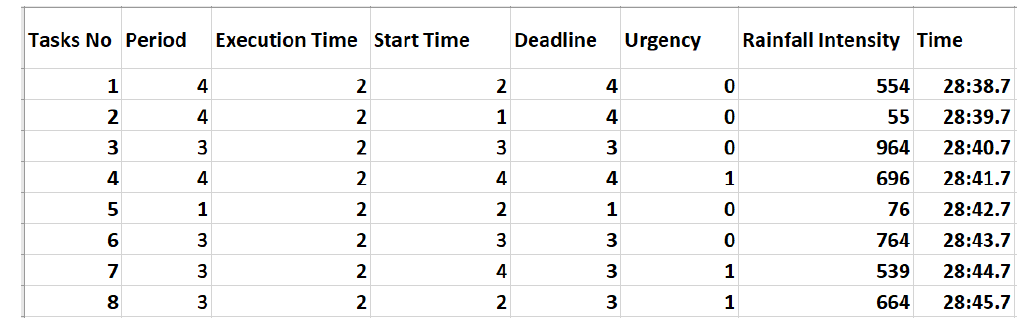
Figure 5. Generated datasets of rainfall tasks for a sampling interval of 1 s.